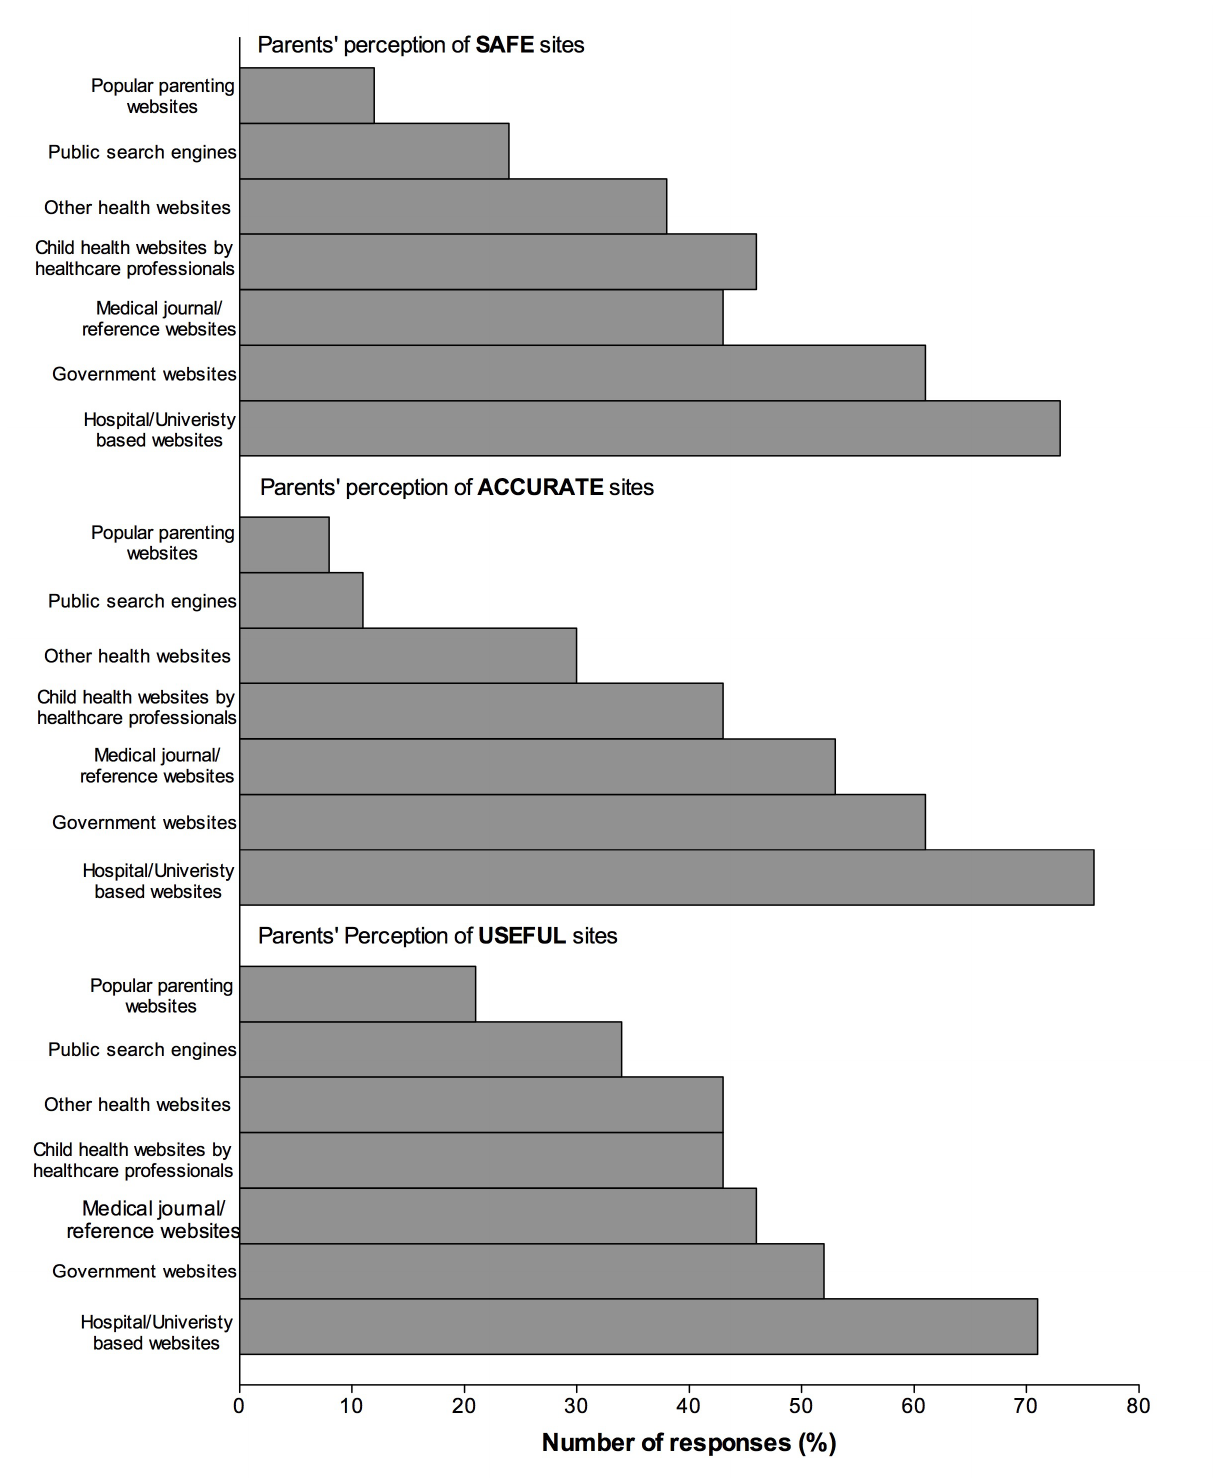
Figure 4. Parent’s perception of safe, accurate and useful